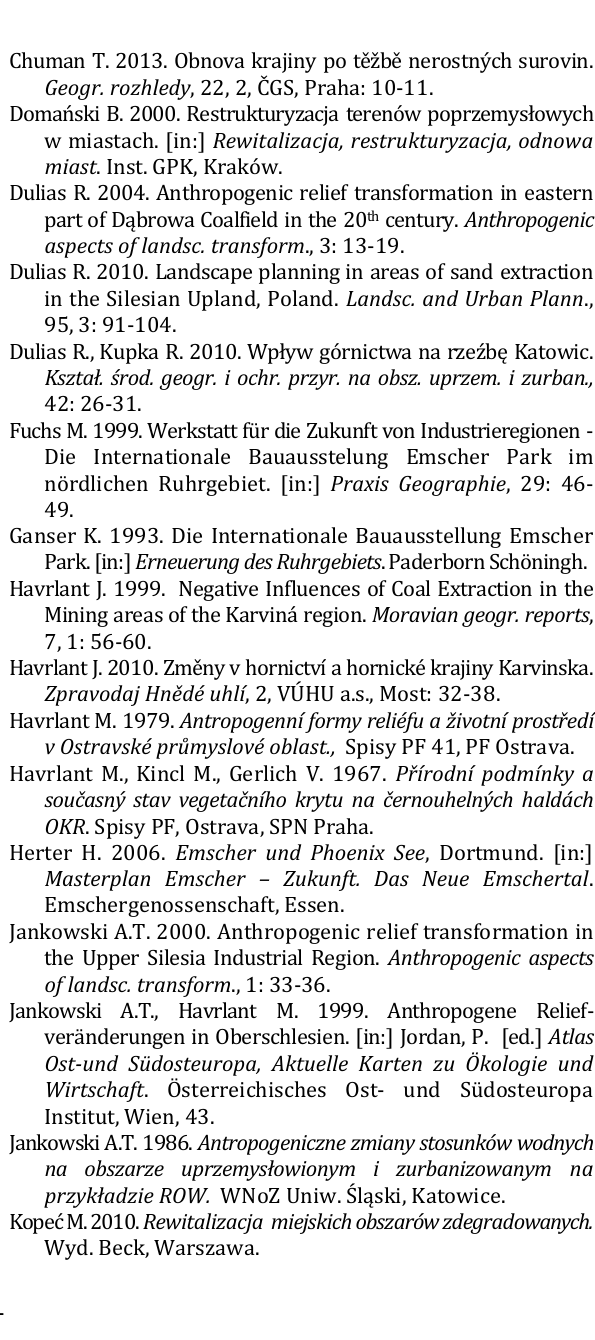
Fig. 8. The Karviná – Fryštat Chateau and Park. 2014 ( J. Havrlant ,